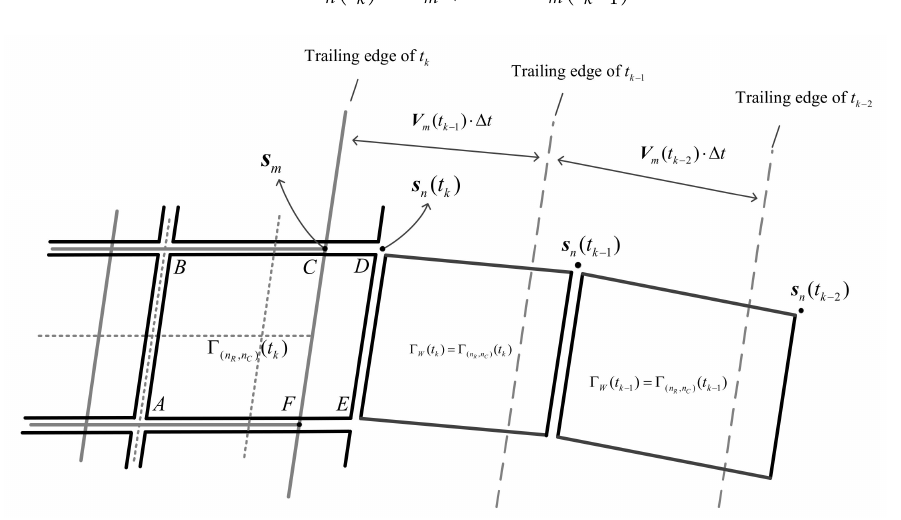
Figure 4. The schematic diagram of the unsteady wake vortex